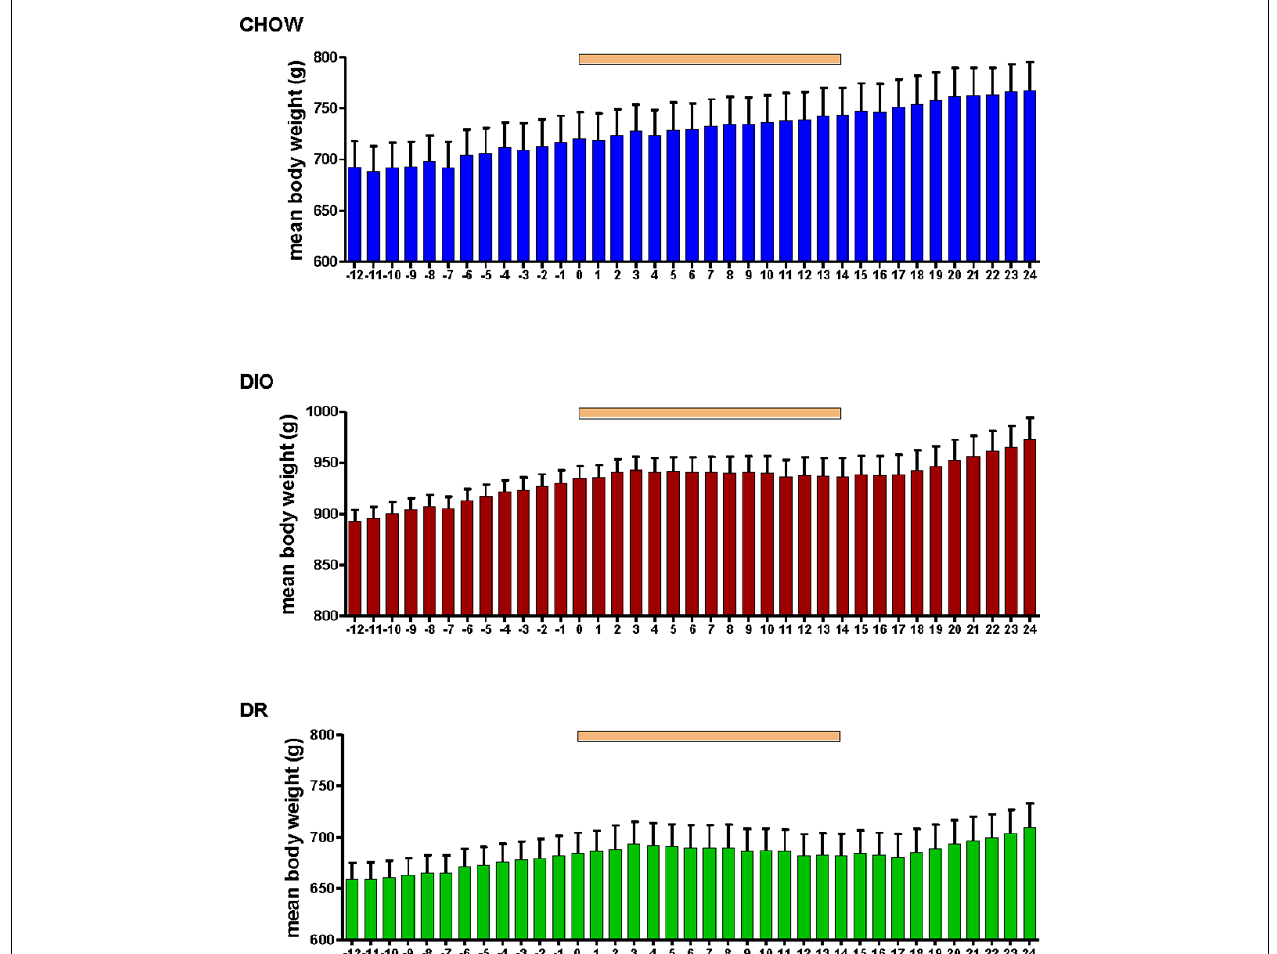
FIGURE 2 | Mean daily body weight in age-matched control rats fed standard rat chow (CHOW, upper panel), DIO rats (middle panel), and DR rats (lower panel) before, during and after oral administration of losartan. Time of losartan administration indicated by the orange bar over the graphs.